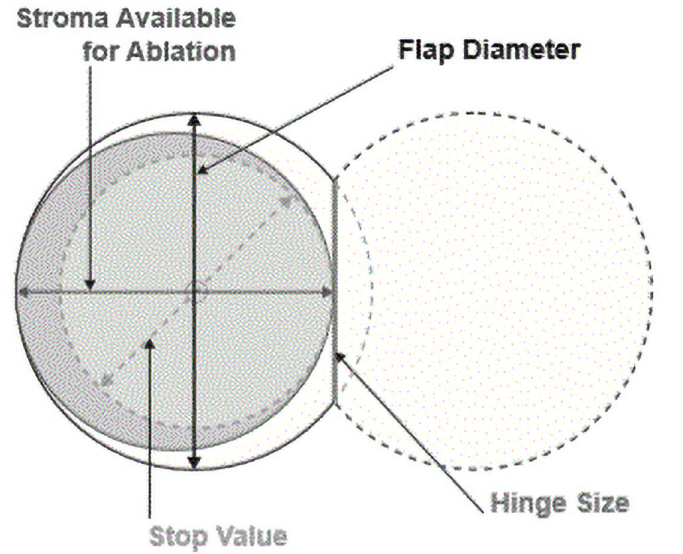
Fig 1. Ring and stop in microkeratome